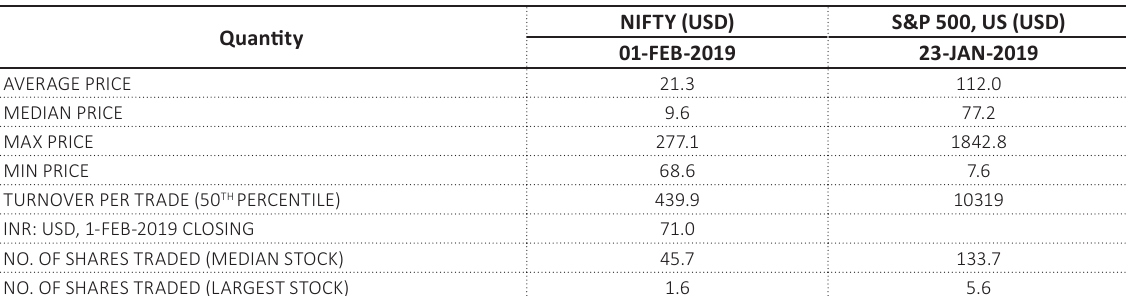
Figure 2. Platform growth: Number of companies listed on the exchanges from 2004 to 2018 Table 5. Number of shares of representative stocks on the NYSE and NSE large cap index traded in a representative